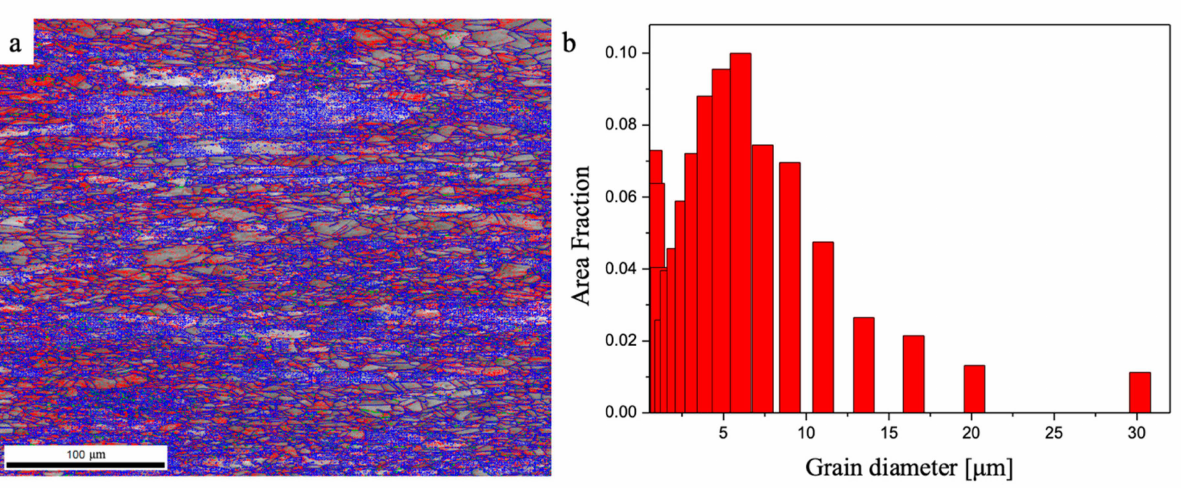
Figure 2. Microstructure and grain size distribution of 7075 aluminum alloy: ( a ) grain size distribution and ( b ) the grain size